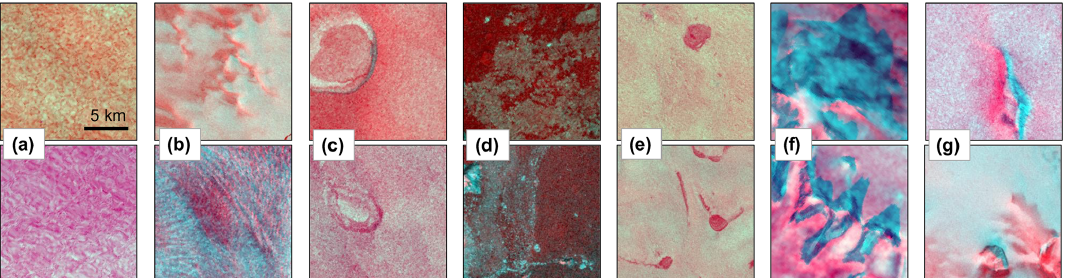
Figure 1. Two example false-colour image tiles for each class used for CNN training. (a) Class 1: uniform ice and snow. (b) Class 2: textured ice and snow including bare ice regions (above) and crevassed regions (below). (c) Class 3: surface lake remnants. (d) Class 4: open ocean and sea water. (e) Class 5: buried lakes. (f) Class 6: land. (g) Class 7: mountains surrounded by